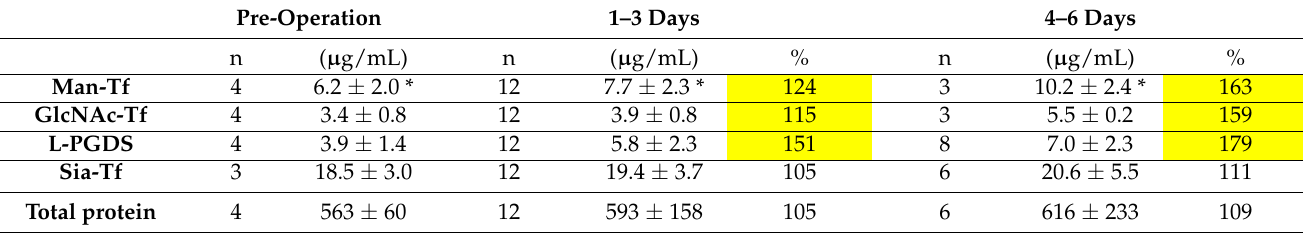
Table 9. CSF marker levels at post-operative days 1–3 and